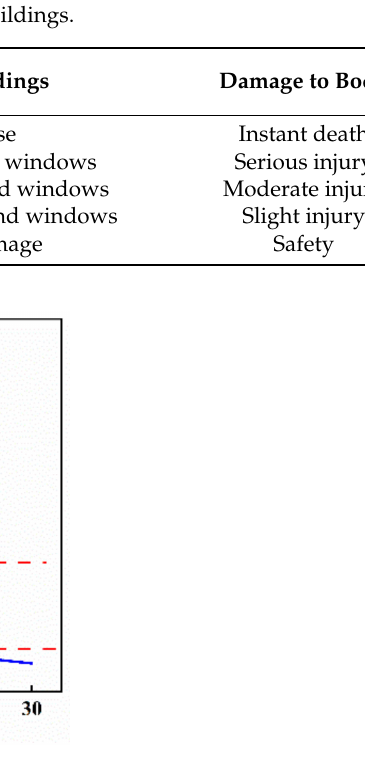
Figure 14. The relationship between overpressure and